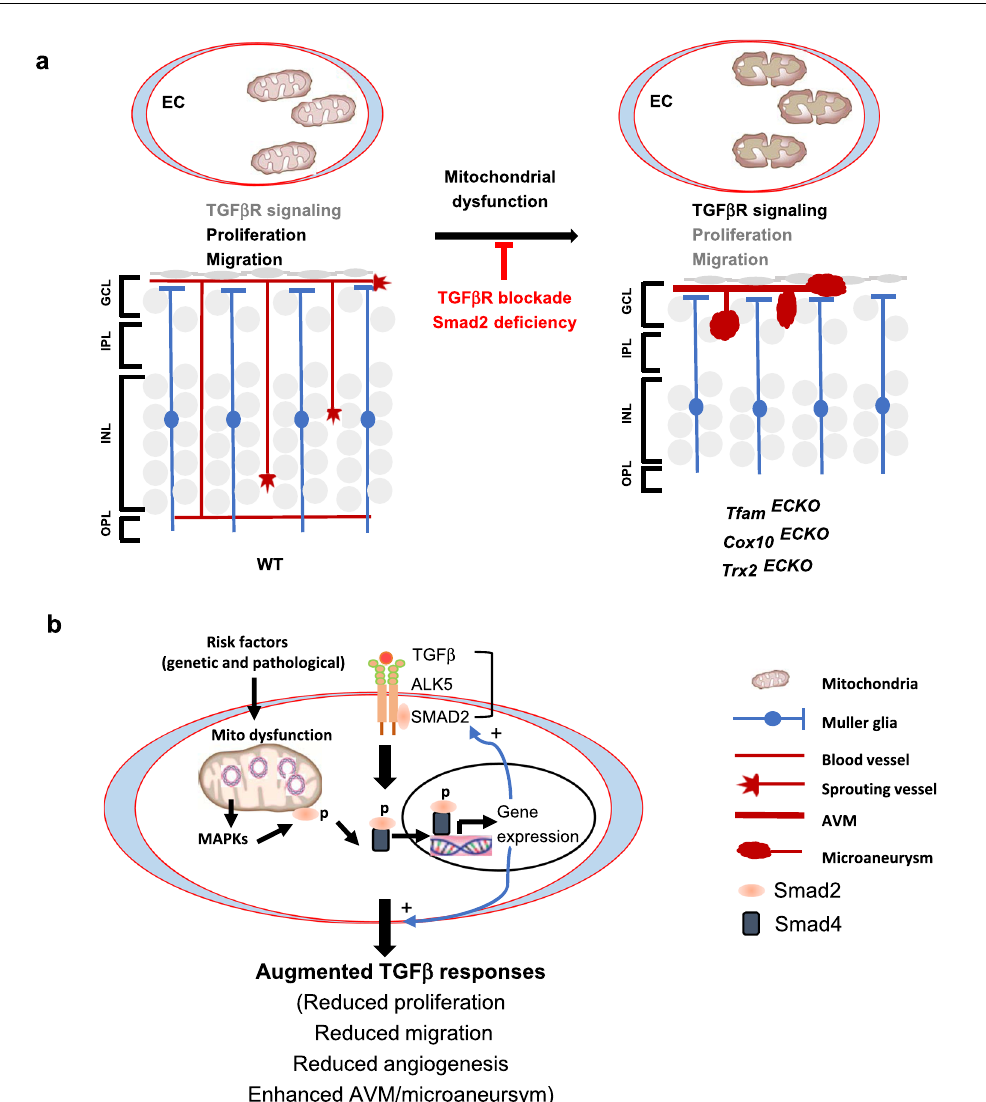
Fig.9| Smad2 geneticde fi ciencyrescuesthevascularmalformationin Tfam ECKO mice. Retinal tissues from WT, Tfam ECKO , Smad2 ECKO and double knockout (DKO) mice were harvested at P15. a – c Attenuation of arterialization and microaneurysm formation in the DKO retinas. Whole mount co-staining with α -SMA, endomucin (EMCN) and CD31. Arrowheads indicate normal or normalized vessels and arrows indicate microaneurysm in the mutant retinas. Asterisks indicate arterialized microvessels. α -SMA coverage ( α -SMA/CD31 ratio) and vascular density were quanti fi ed. n =6 mice per group. A: artery/arterial; V: vein. d – f Whole mount